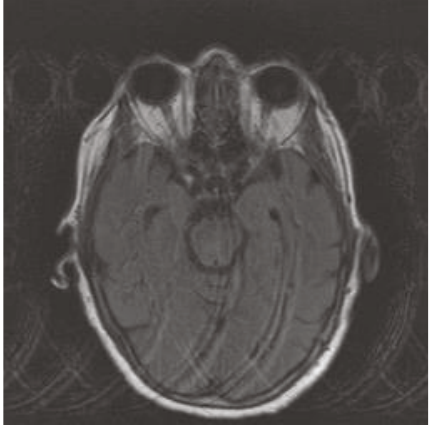
Figure 1: Axial T2-weighted sequence through the midbrain.